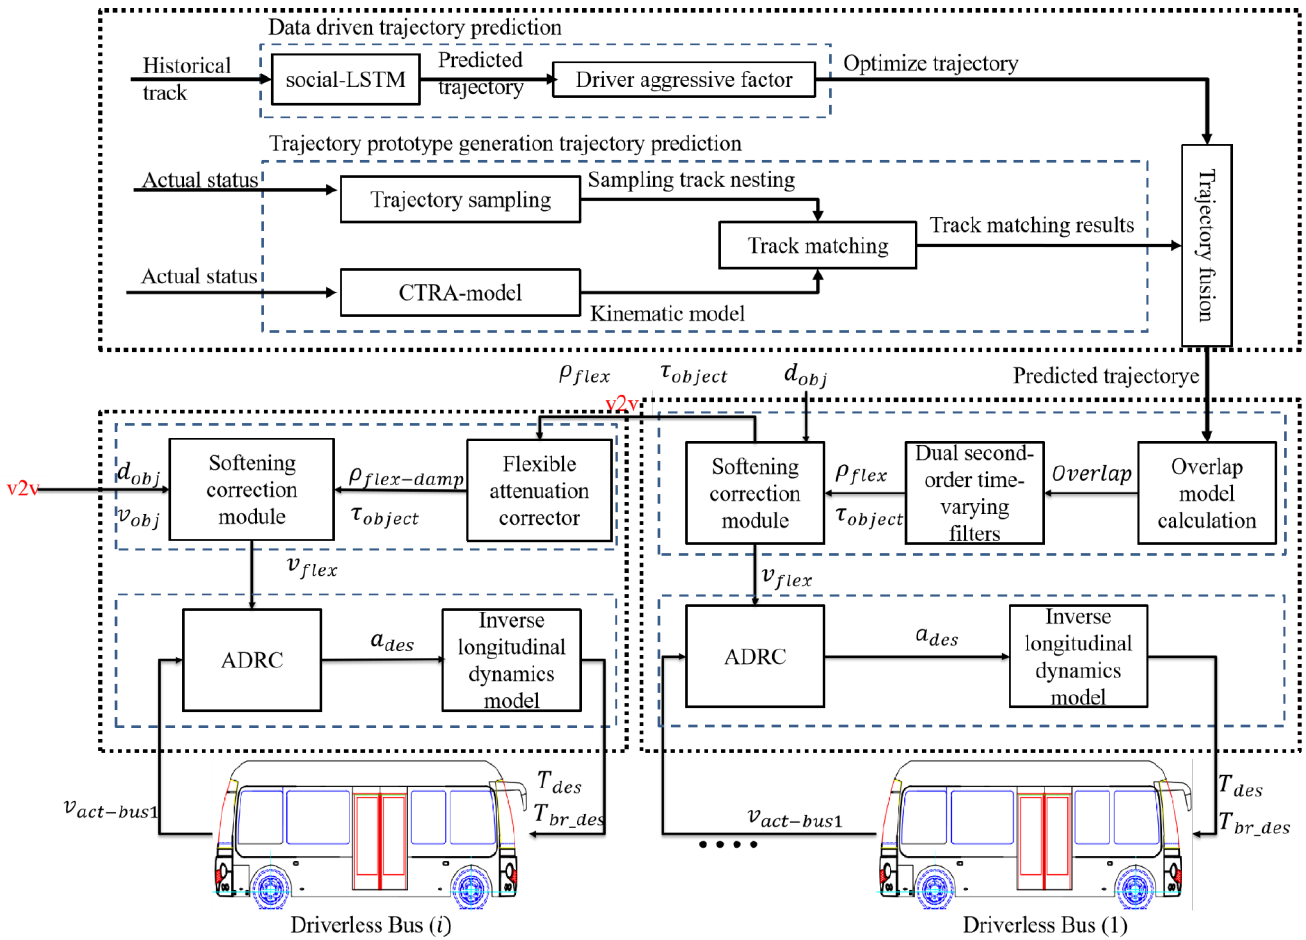
Figure 1. Framework of cooperative adaptive cruise system based on intelligent prediction.